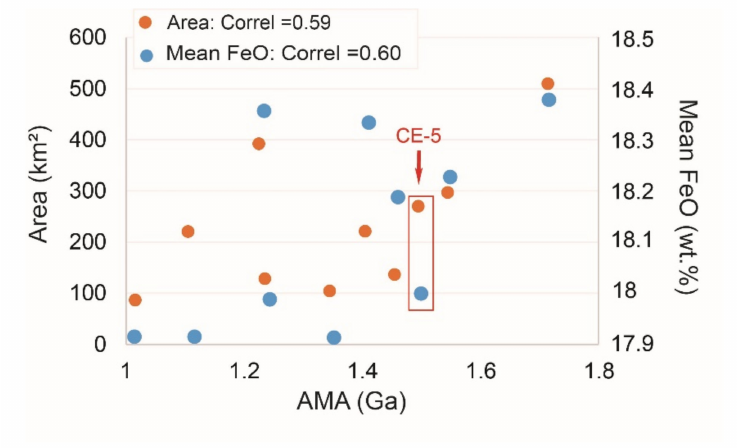
Figure 8. The correlations of AMAs with crater counting areas and mean FeO contents. Correl = correlation coefficient. Orange points denote the AMAs against subunit areas and the correlation coefficient is 0.59. Blue points denote the AMAs against mean FeO contents and the correlation coefficient is